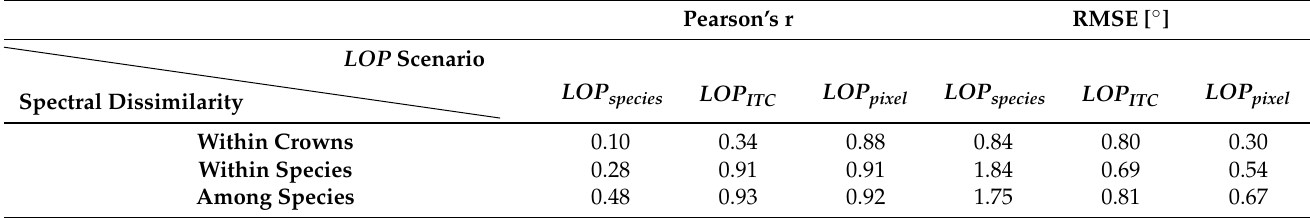
Table 2. Pearson’s correlation coefficient and RMSE computed when comparing spectral dissimilarity from imaging spectroscopy and from DART simulations for the different LOP variability scenarios. Spectral dissimilarity is compared within crowns, within species and among species.